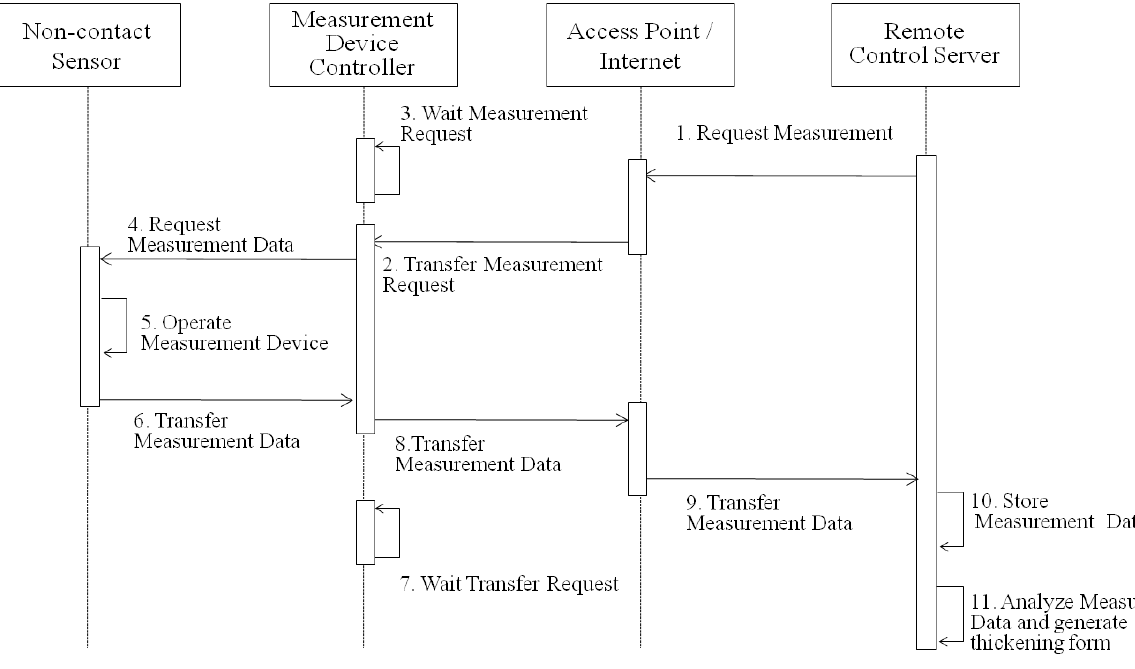
Figure 15. Data collection procedure of the plant growth measurement